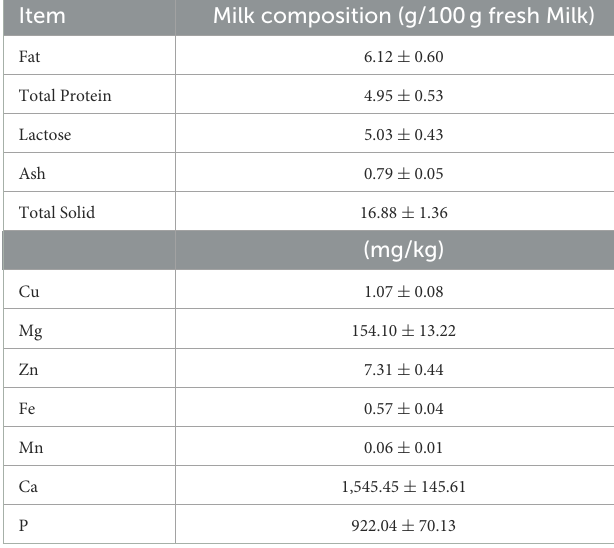
TABLE 2 Yak milk composition.